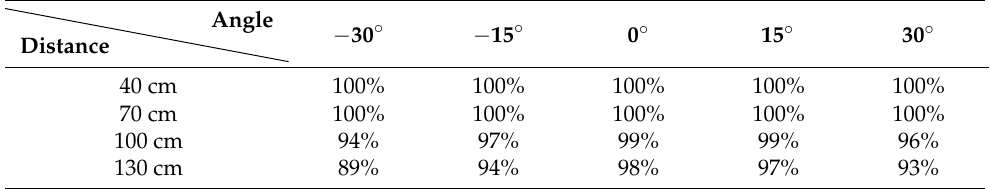
Table 4. The success rates of floating garbage detection by the Pixy CMUcam5 vision sensor.